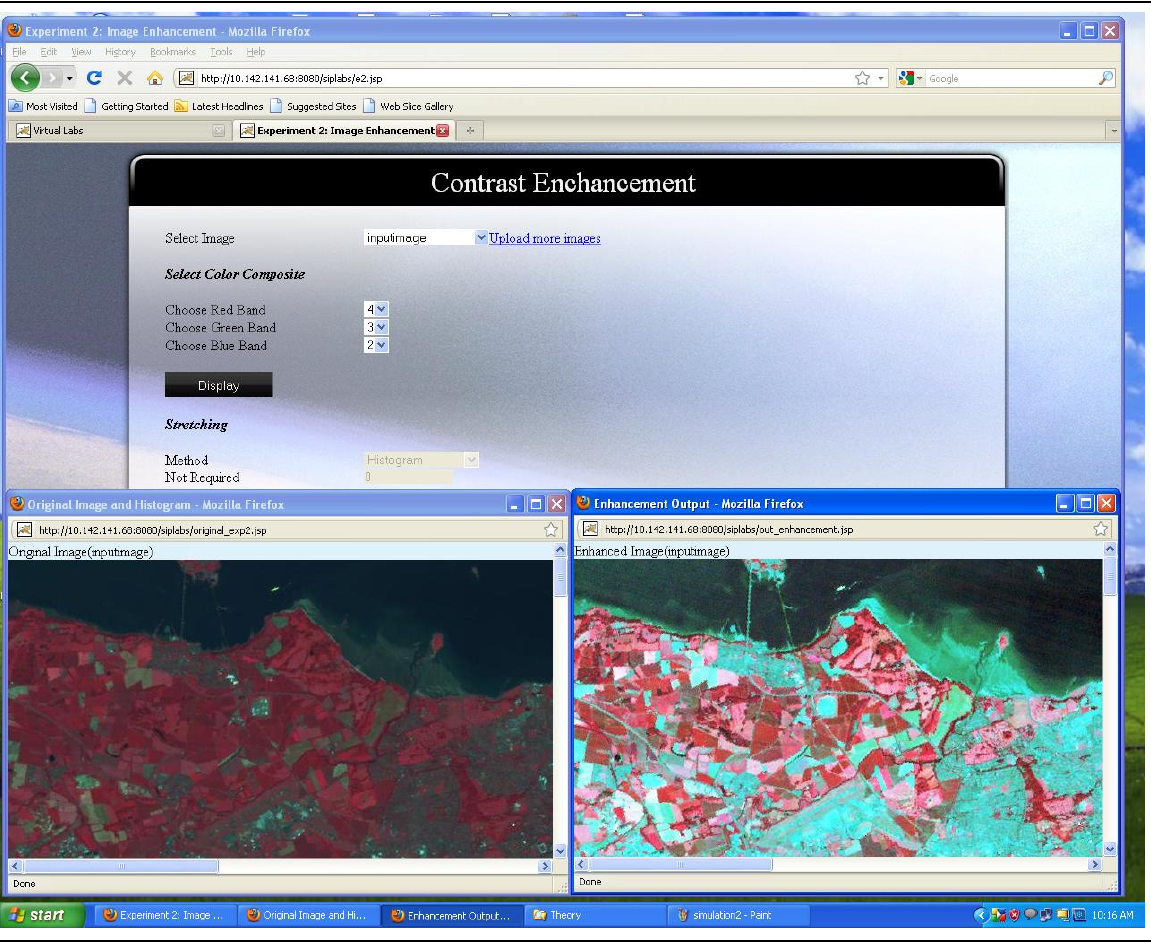
Figure 3. Contrast Enhancement